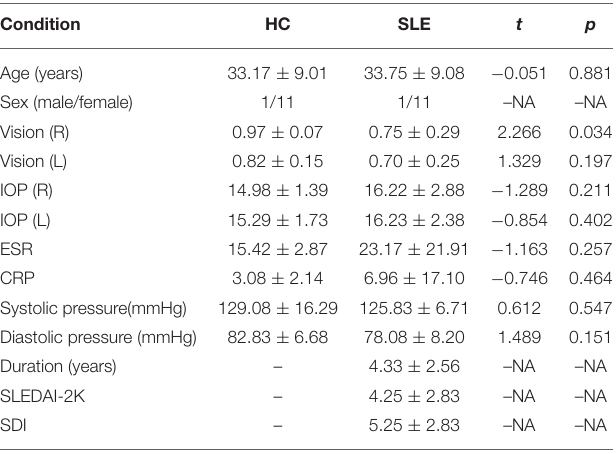
TABLE 1 | Demographic characteristics and clinical findings of patients with SLE and HCs.